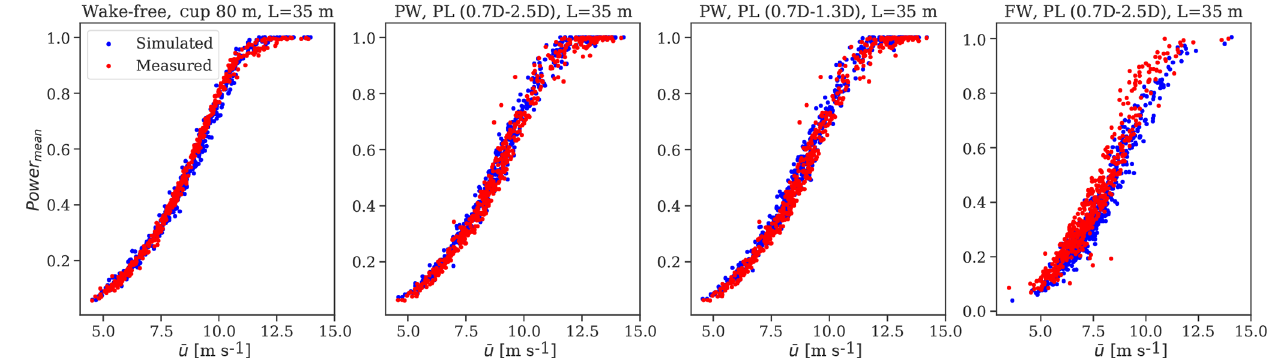
Figure C1. Scatter plots of the normalized measured and predicted power mean realizations used in the analysis.